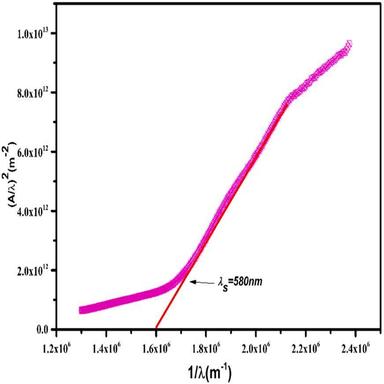
(A/λ) 2 vs (1/ λ) for the determination of the Threshold Energy of La2SrFe2TiO9.